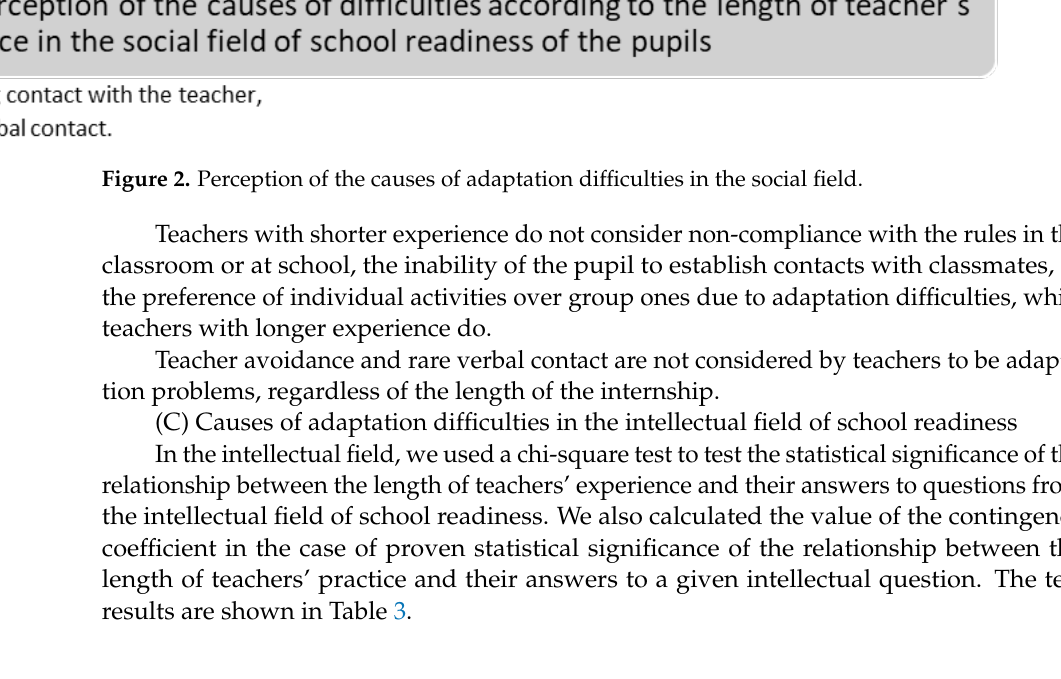
Figure 2. Perception of the causes of adaptation difficulties in the social field.